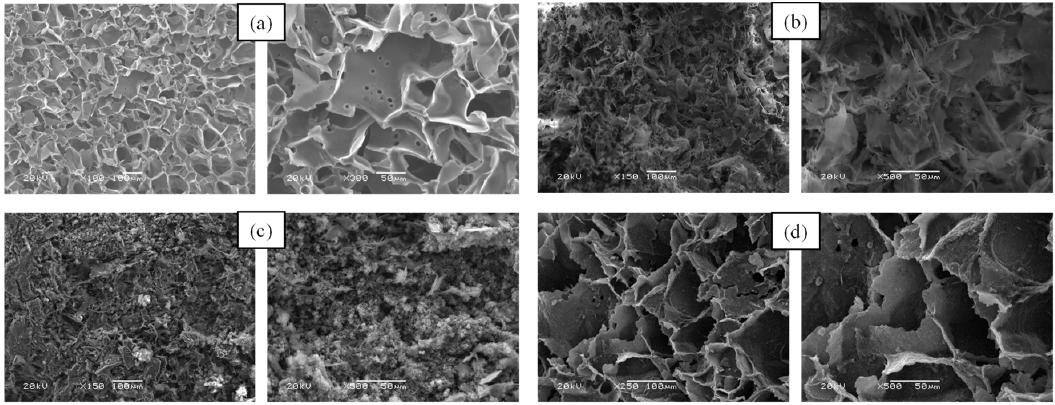
Figure 1. SEM images of prepared ( a ) bare Polyethyleneimine (PEI) cryogel, ( b ) PEI/PANi, ( c ) PEI/PPy, and ( d ) PEI/PTh cryogel composites. and ( d ) PEI / PTh cryogel